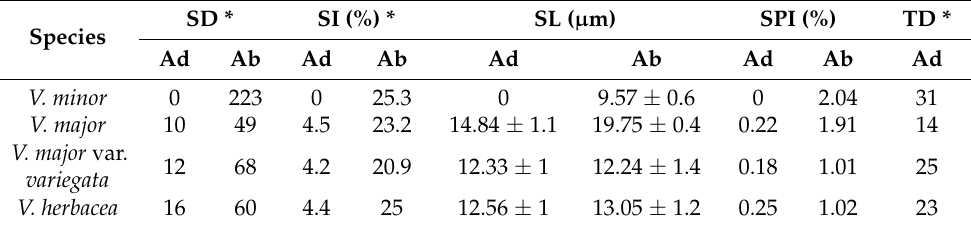
index, SL = Stomatal pore length, SPI (%) = Stomatal pore index, TD = Trichomes’ density; the criteria marked with * are measured in a one mm 2 surface area; SL was measured three times on a minimum of six independent stomata ± standard error of the mean (s.e.m.).